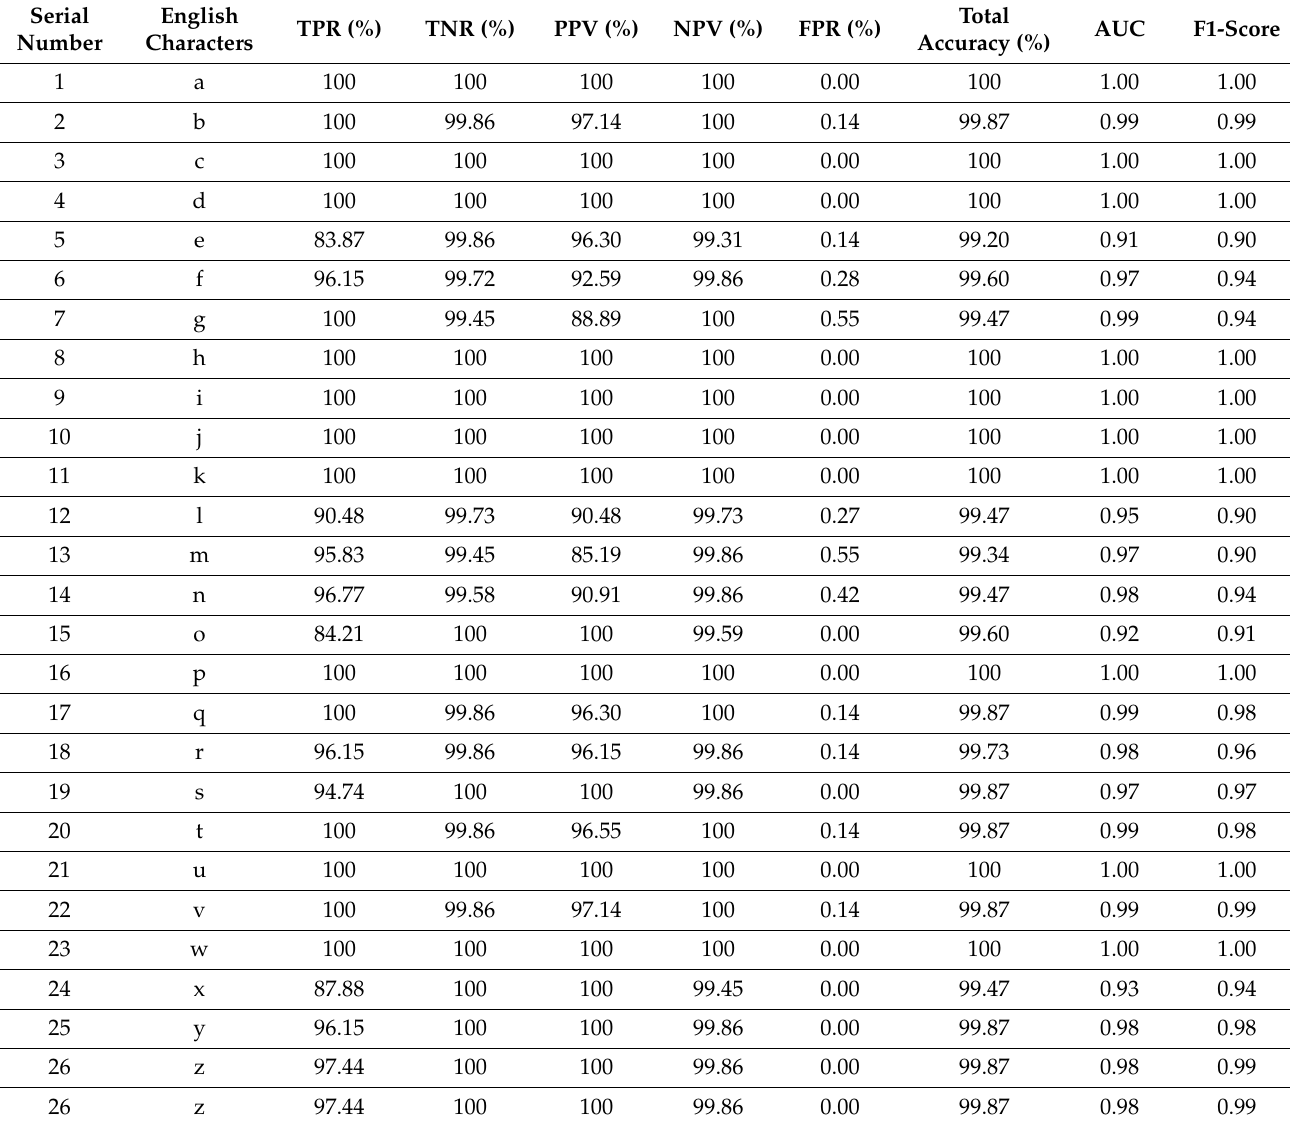
Table 2. Performance metrics showing the results obtained for the Decision Tree